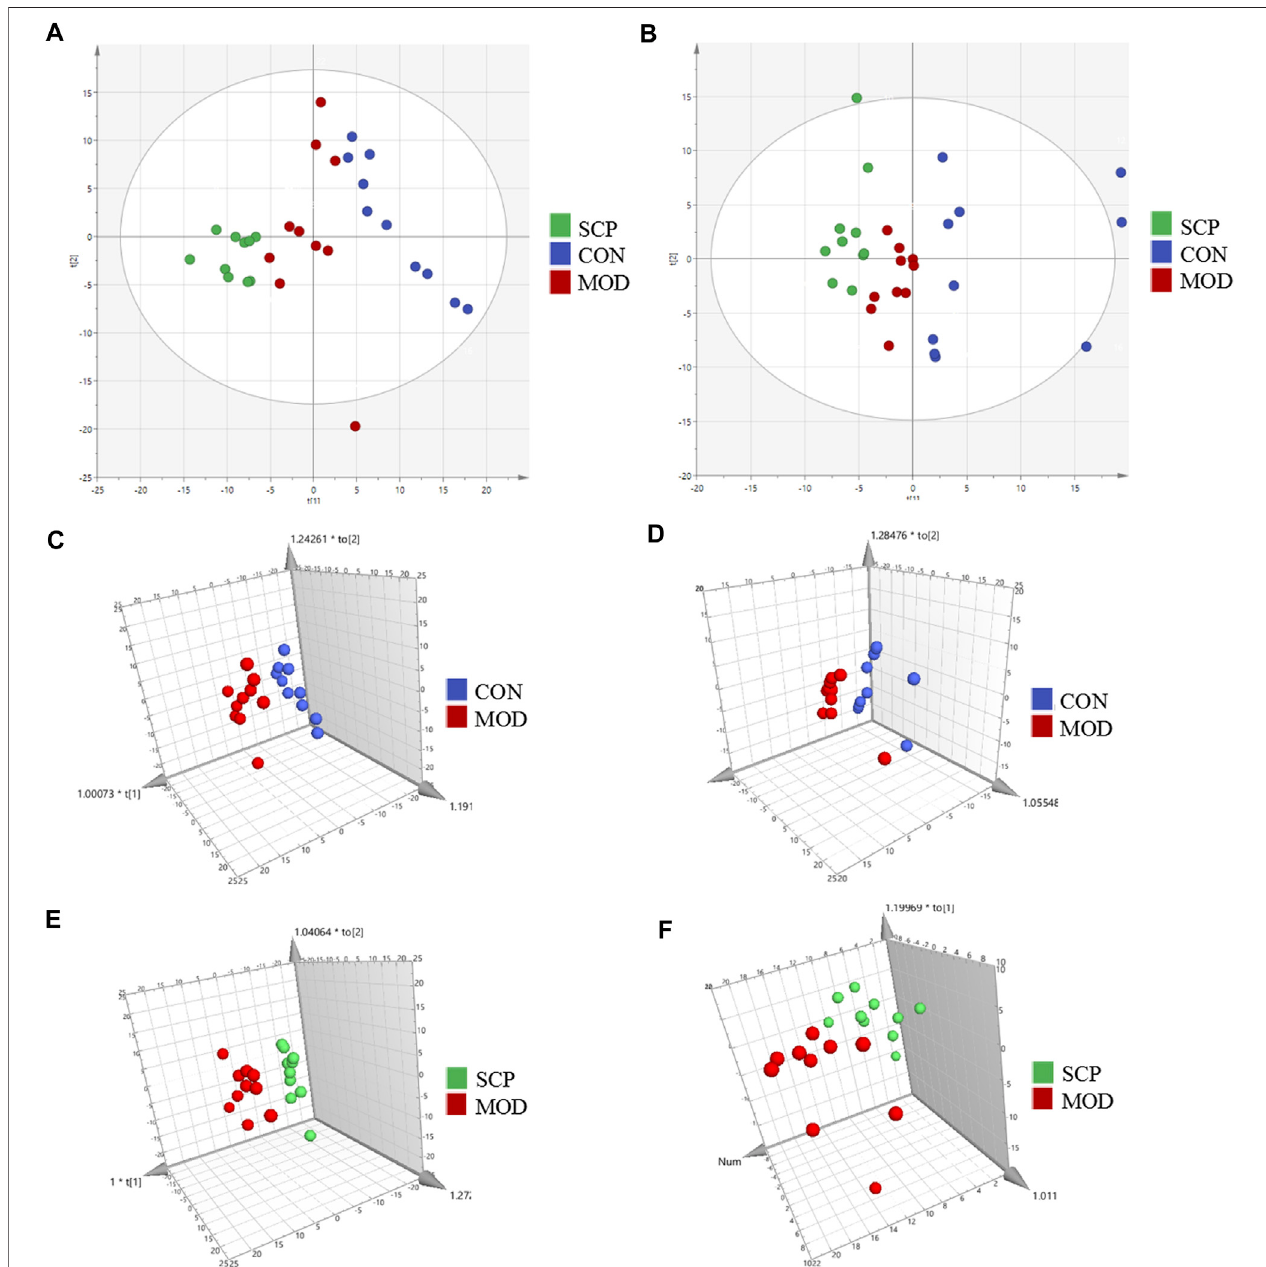
FIGURE 6 | PCA score plots of the CON, MOD, and SCP groups in the positive mode (A) and negative mode (B) ; OPLS-DA score plots of the CON and MOD groups in the positive mode (C) and negative mode (D) ; OPLS-DA score plots of the MOD and SCP groups in the positive mode (E) and negative mode (F) .